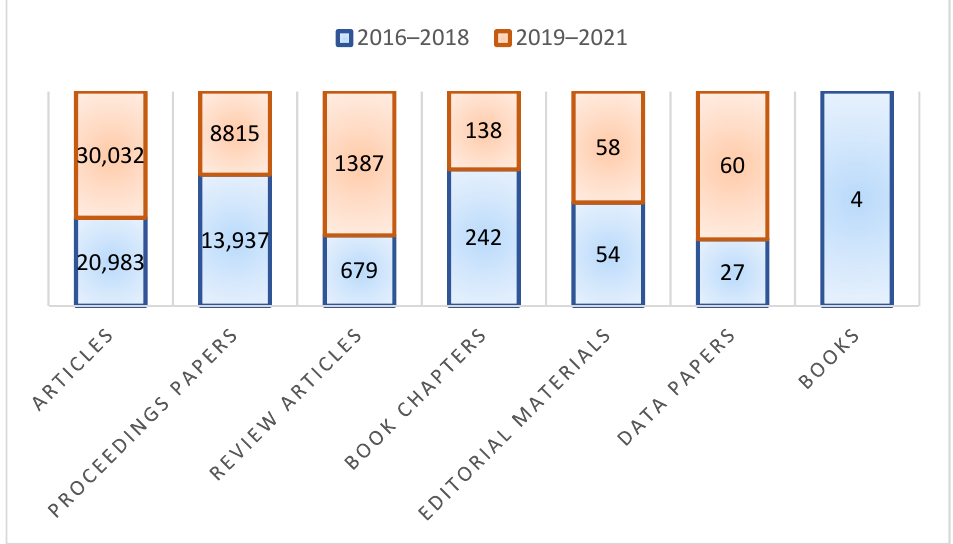
Figure 5. Types of Documents published during time spans 2016–2018 and 2019–2021.